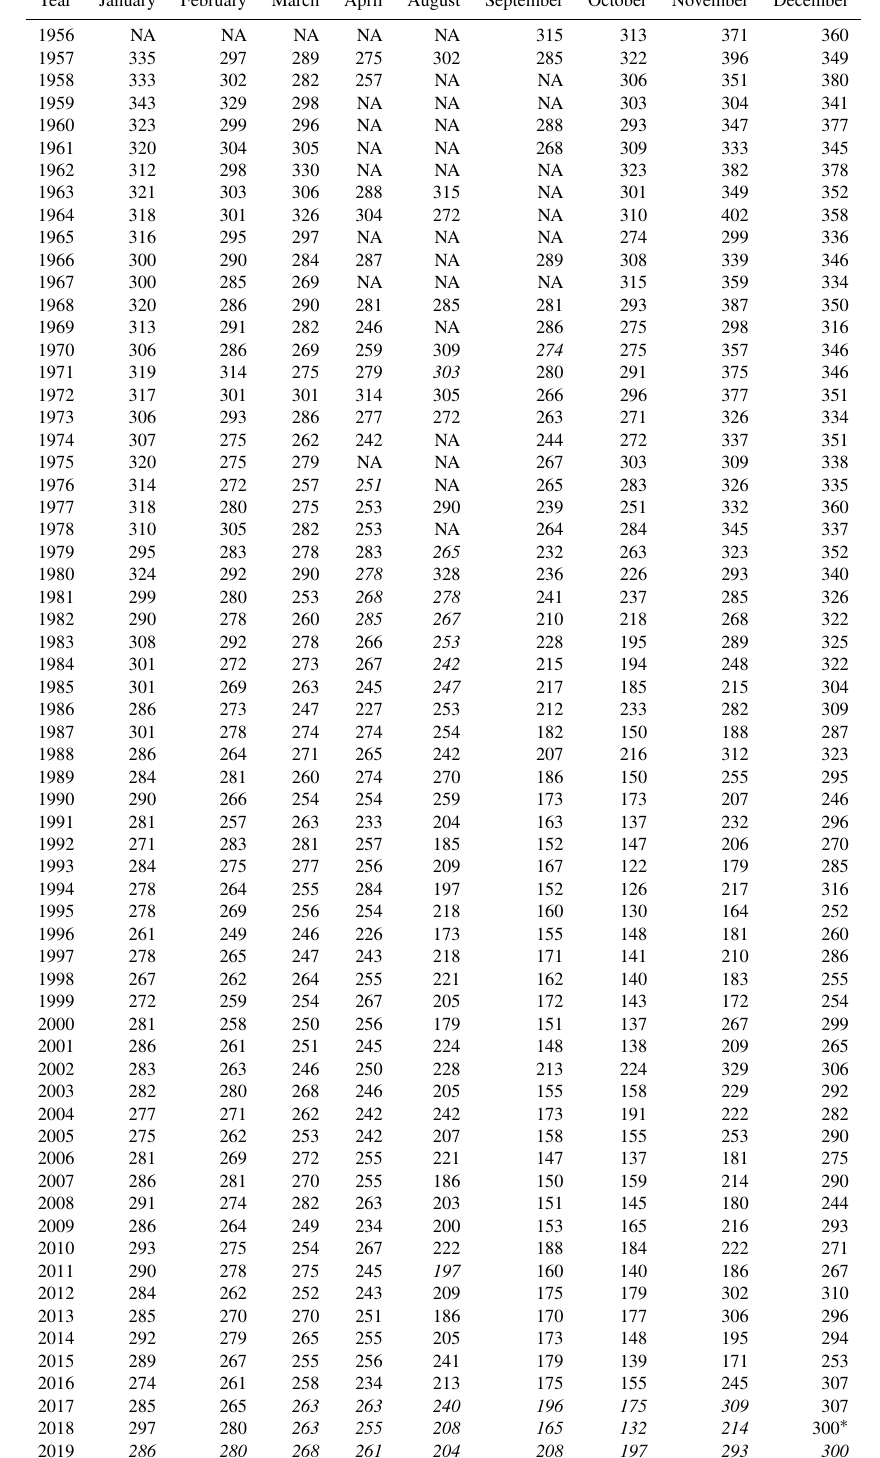
Table 3. Monthly total ozone averages at Halley. Italic indicates months with no available Halley Dobson observations or only provisional automated Dobson data, for which the (cid:49) -adjusted satellite average was